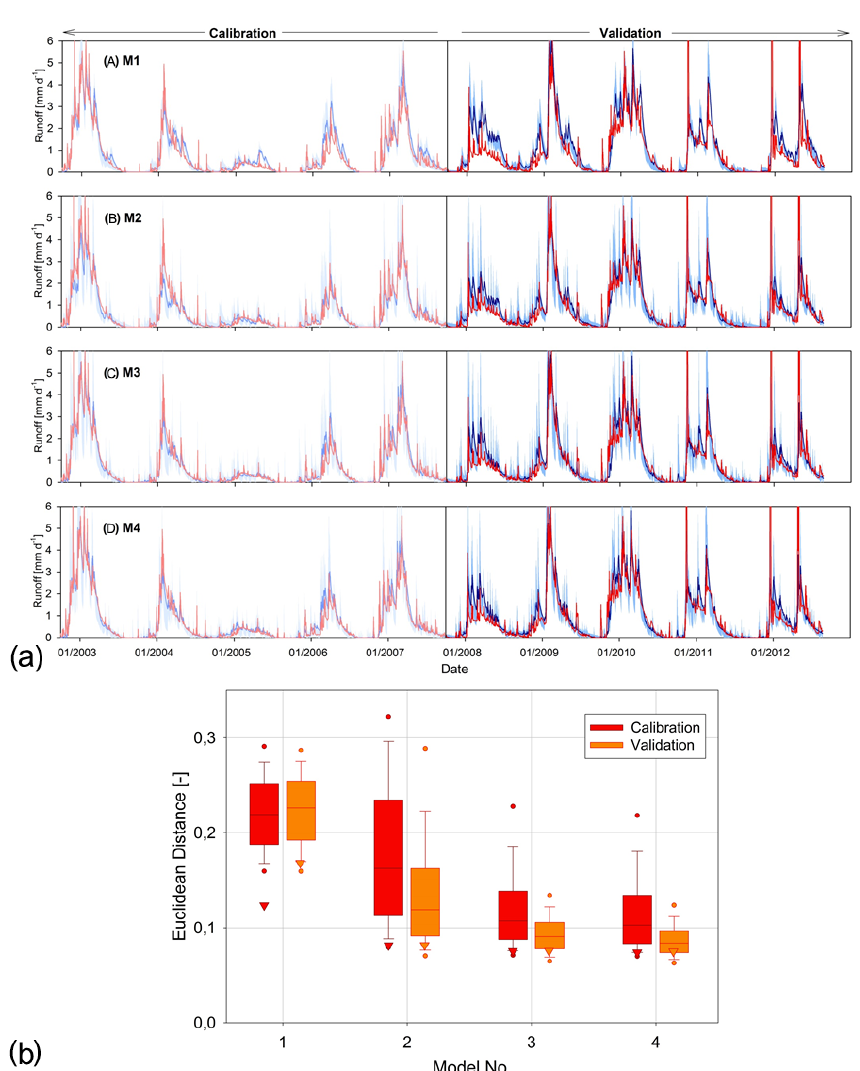
Figure 3. (a) Observed (red line) and modelled runoff for model set-ups (A) M1, (B) M2, (C) M3 and (D) M4 in calibration and independent evaluation (validation) periods. Modelled runoff shown as the most balanced solution (dark blue line) and the 5/95th uncertainty bounds (light blue shaded area). Adapted from Hrachowitz et al. (2014). (b) Overall model performance for all model set-ups (M1–M4) expressed as Euclidean distance from the “perfect model” computed from all calibration objectives and signatures with respect to calibration and validation periods. Triangles represent the optimal solution, i.e. the solution obtained from the parameter set with the lowest Euclidean distance during calibration. Box plots represent the Euclidean distance for the complete sets of all feasible solutions (the dots indicate 5/95th percentiles, the whiskers 10/90th percentiles and the horizontal central line the median). From Hrachowitz et al.